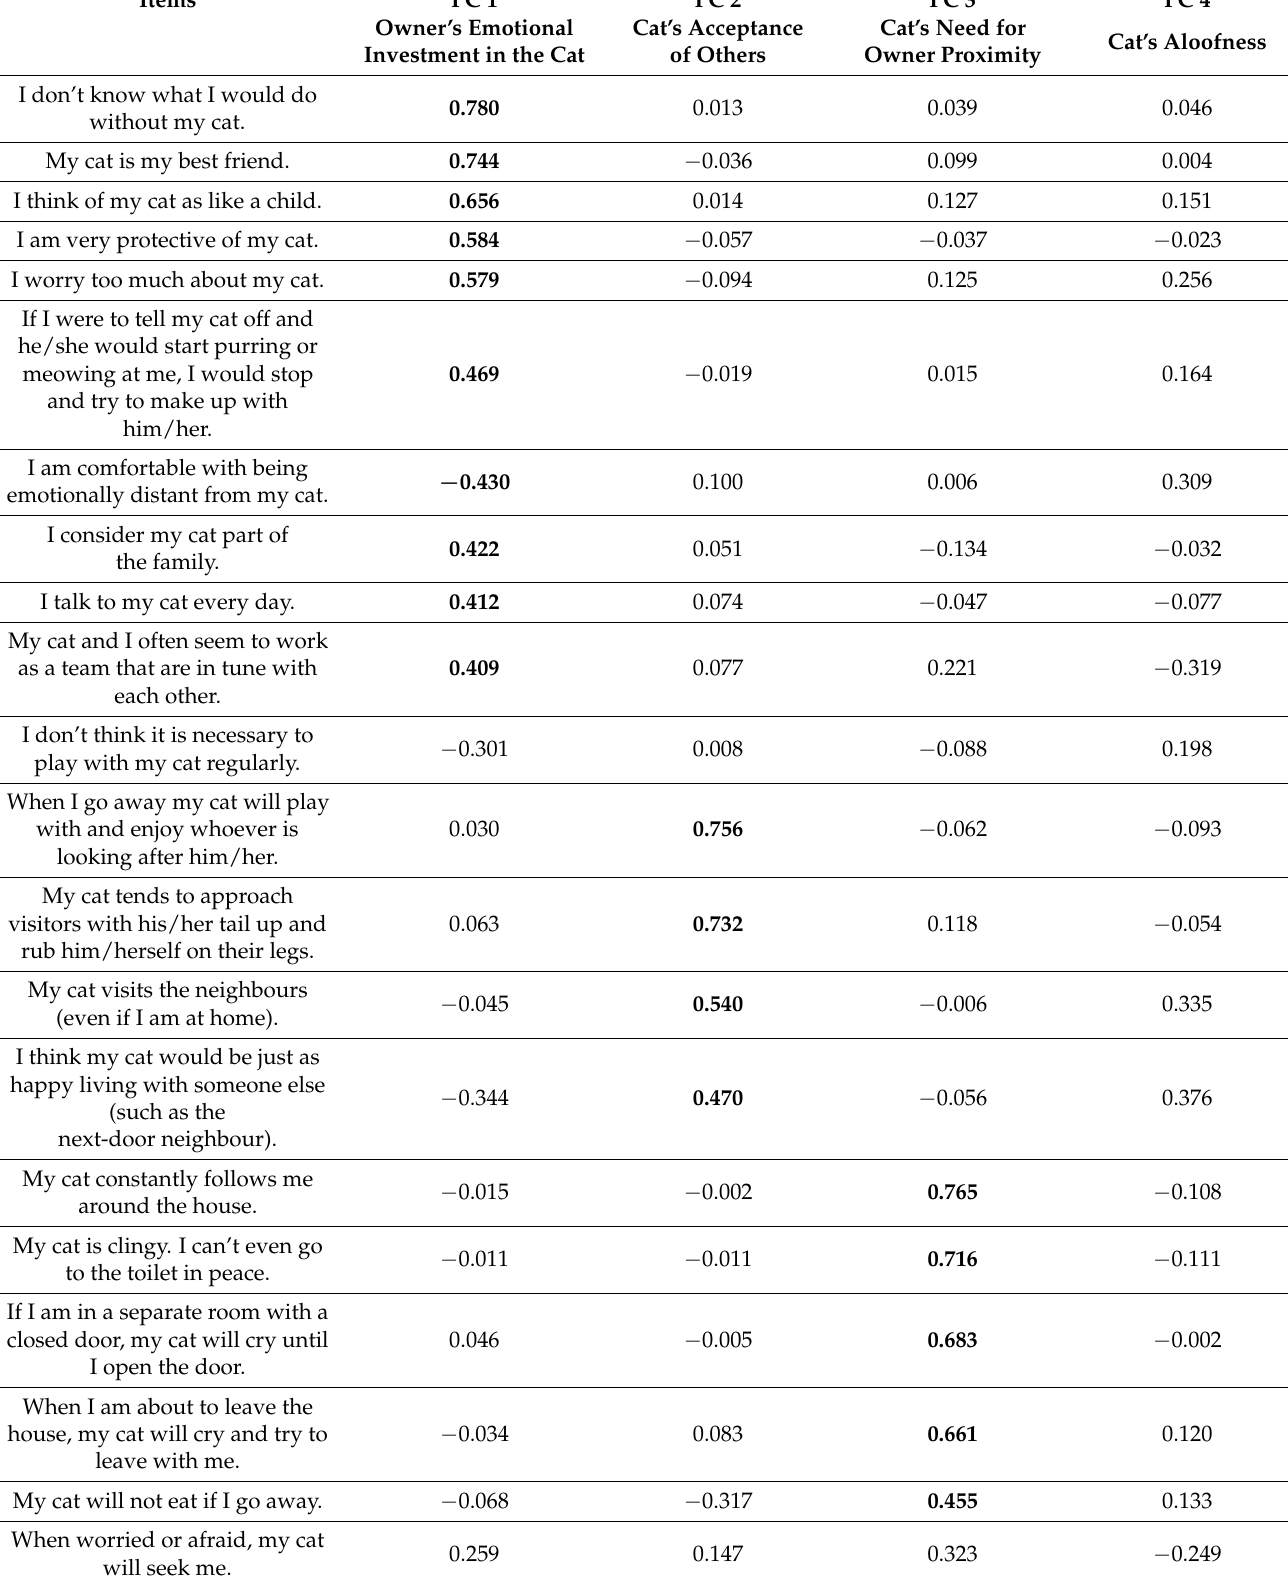
Table 2. List of reliable items, with the respective loading scores on each PC. The items that loaded onto each individual PC are shown in